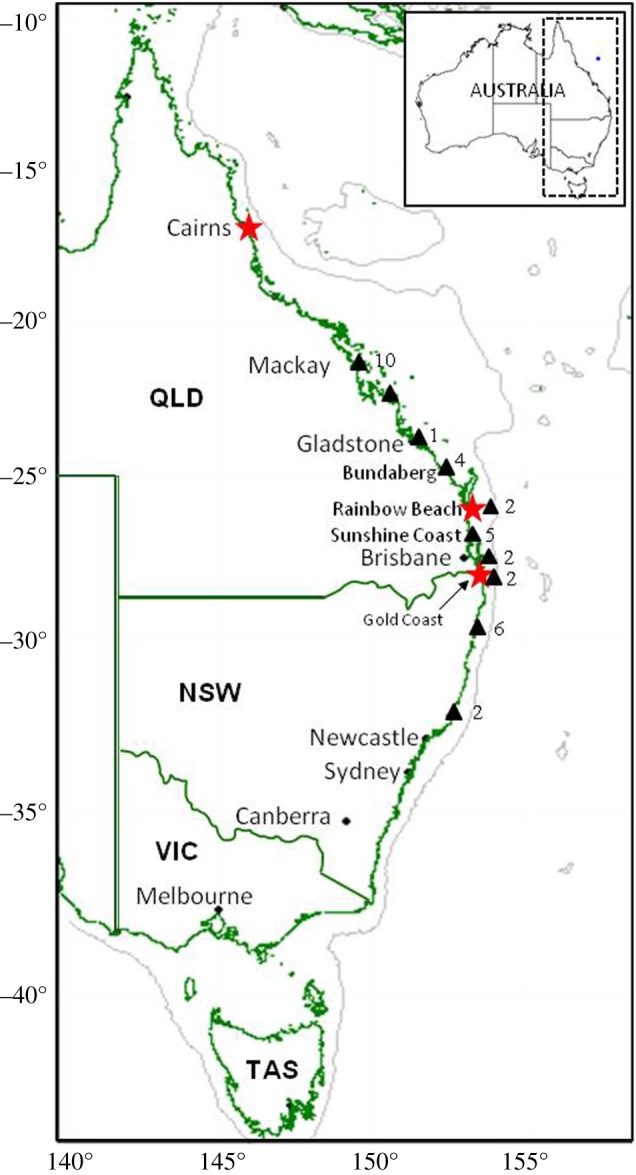
Capture locations of Galeocerdo cuvier mother–litter groups (n = 4, red stars), and population samples used to determine allele frequencies (n = 34, black triangles) from the Australian east coast. Numbers beside black triangles indicate sample sizes from that location. Note two mother–litters were captured at Rainbow Beach.